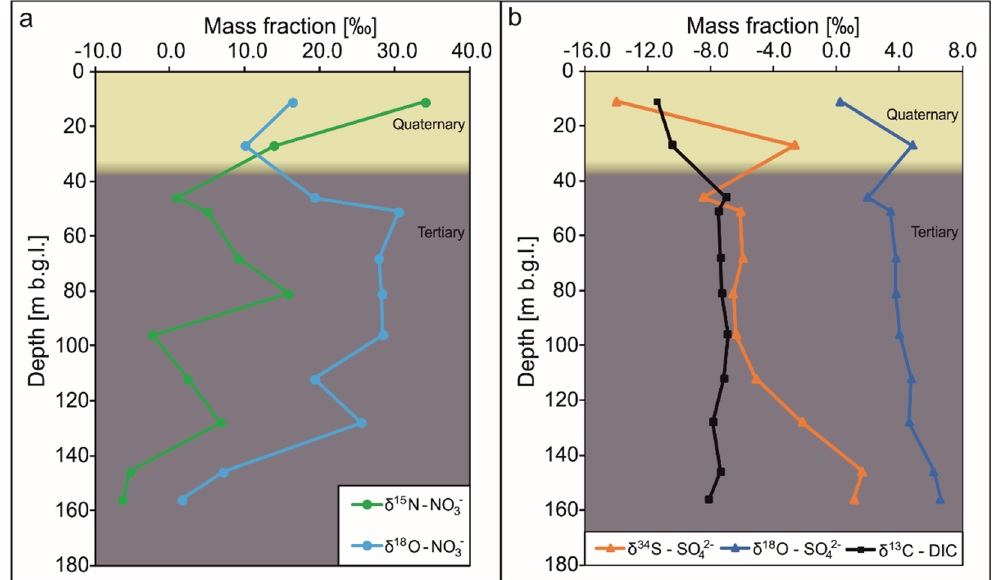
Figure 8. Isotope ratios in the groundwater of the Quaternary–Tertiary aquifer. ( a ) δ 15 N-NO 3 − and δ 18 O-NO 3 − . ( b ) δ 34 S-SO 42 − , δ 18 O-SO 42 − , and δ 13 C-DIC.